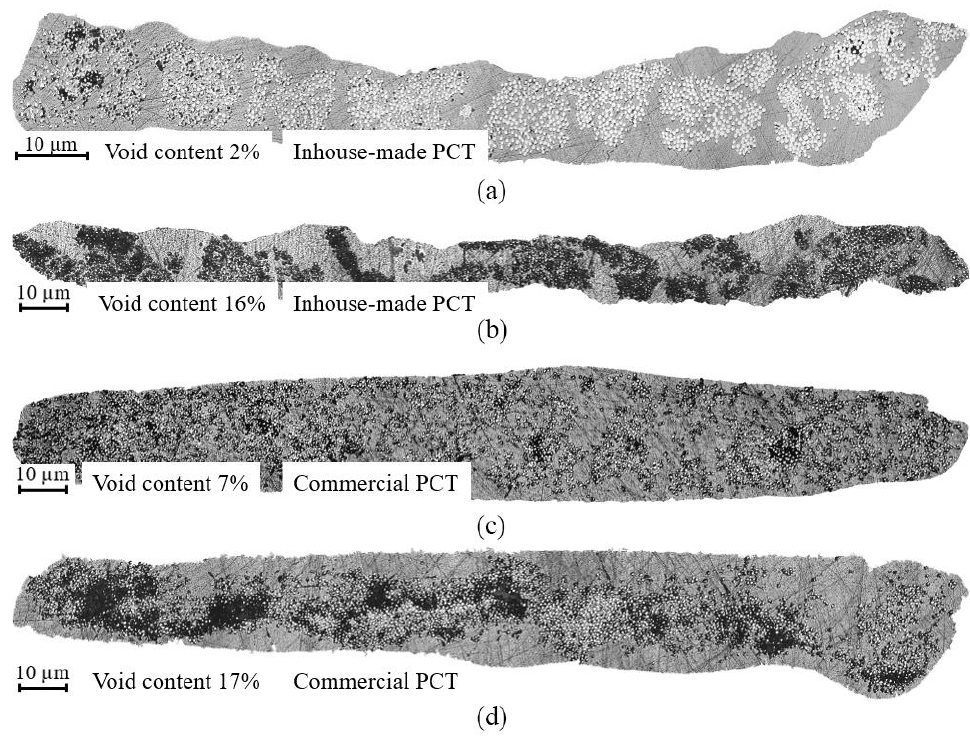
Figure 7. Micrographs of PCTs: ( a ) inhouse-made PCT with the lowest void content of 2%; ( b ) inhouse-made PCT with the largest void content of 16%; ( c ) commercial PCT with the lowest void content of 7%; ( d ) commercial PCT with the largest void content of 17%.